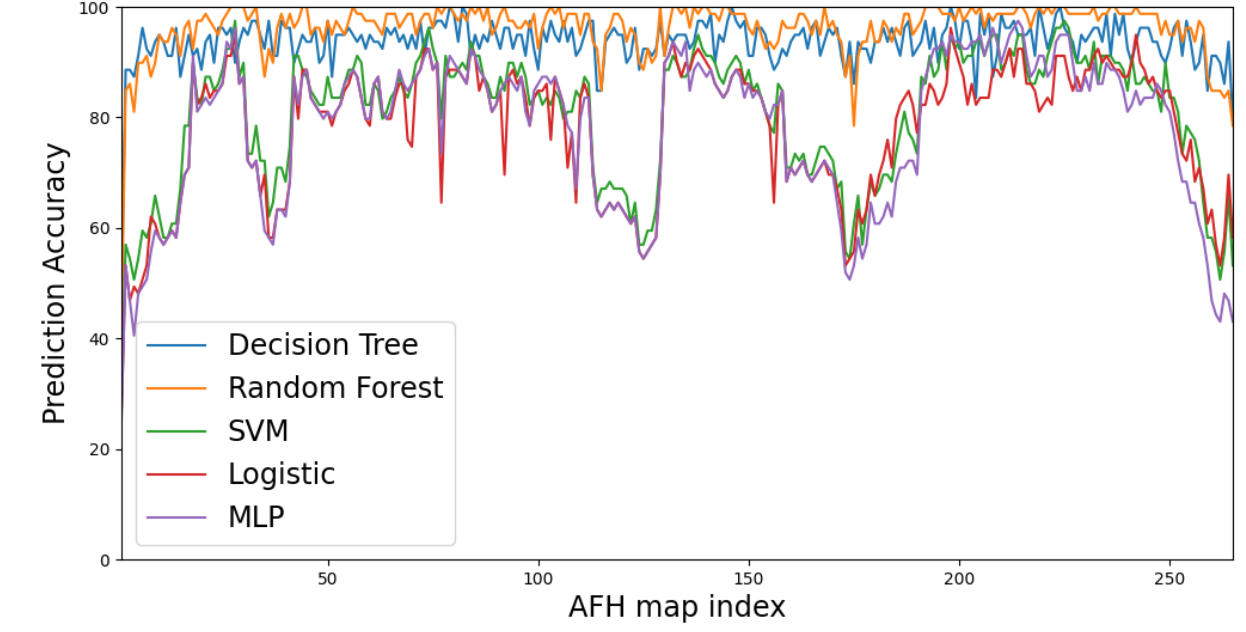
Figure 4. The prediction accuracy of each AFH map for the five